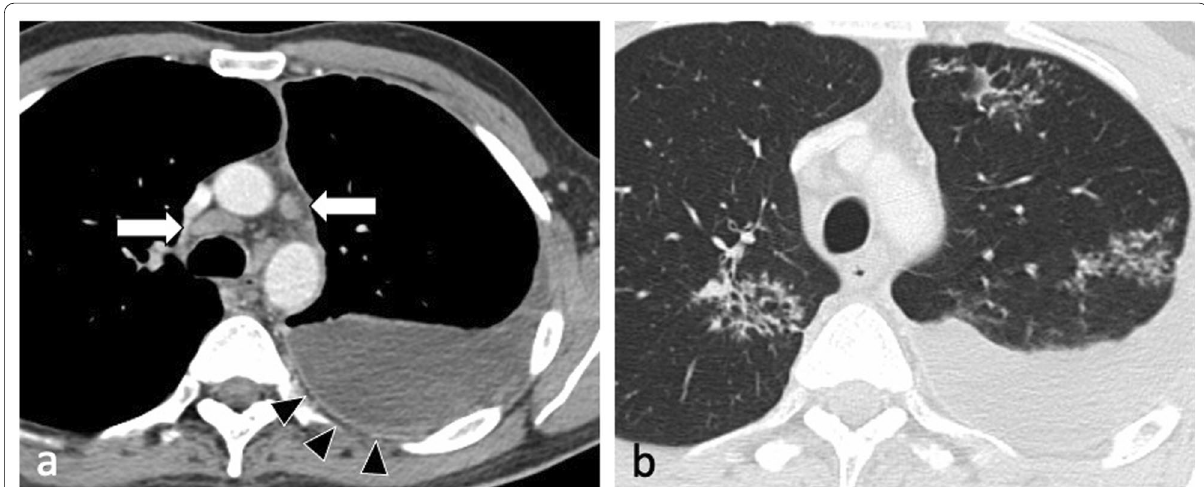
Fig. 8 A 37-year-old male presented with intermittent pyrexia, sweats, rigors, reduced appetite and weight loss. Post-contrast CT shows a moderate volume left pleural effusion with pleural thickening and enhancement (mediastinal window, axial plane— a , arrowheads). There are also multifocal areas of perilymphatic nodularity (lung window, axial plane— b ) and bilateral paratracheal and mediastinal lymphadenopathy (arrows, a ). Pleural biopsy confirmed the presence of acid-fast bacilli